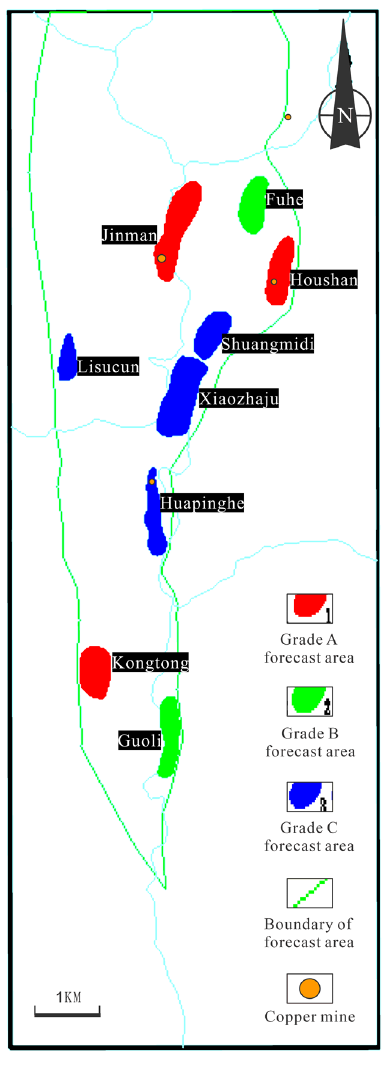
Figure 5. Prospecting prediction